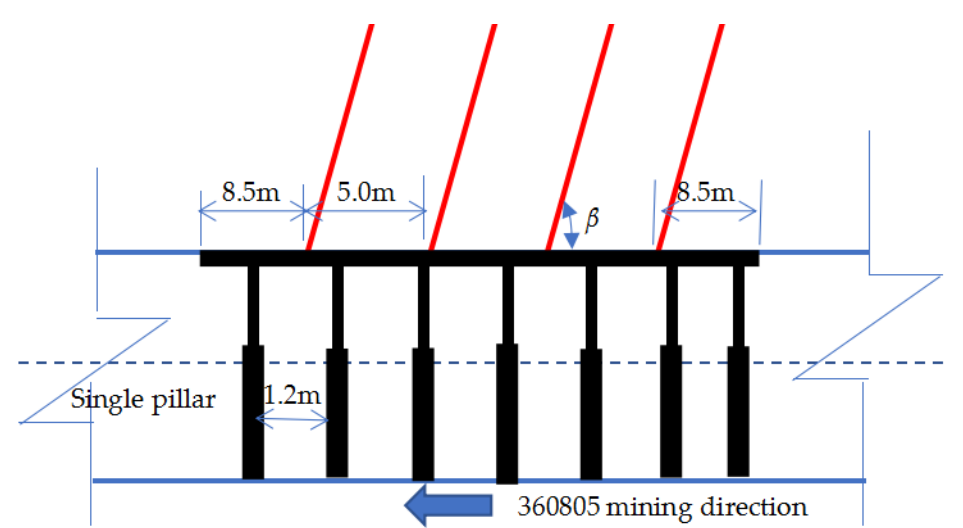
Figure 4. Scope of reinforced support in the vibration zone.